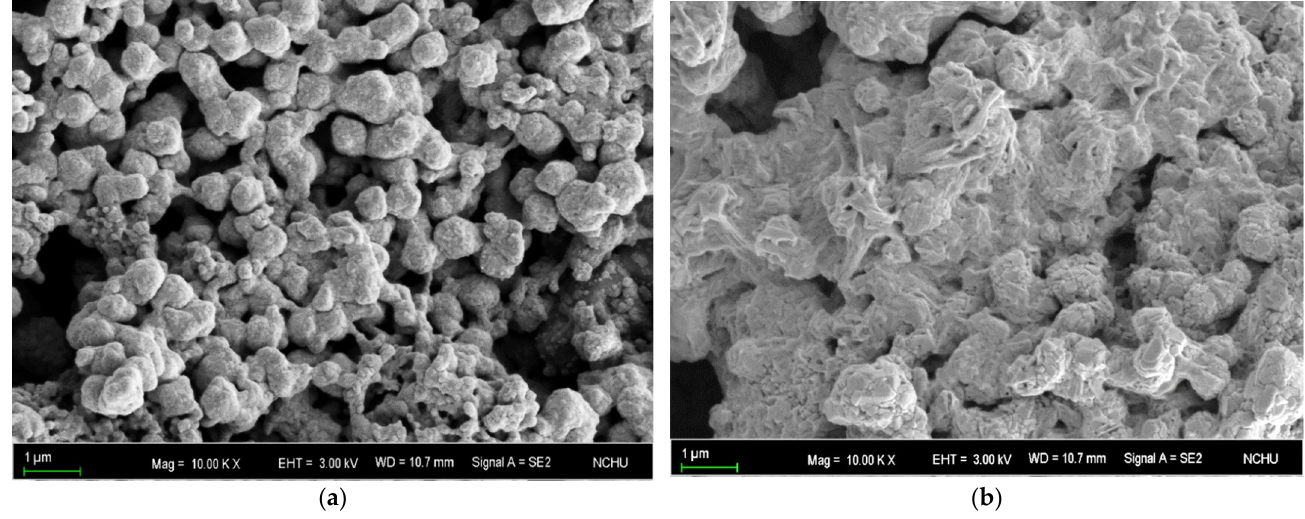
Figure 6. SEM image of sintered hybrid copper pastes ( a ) without copper salts, and ( b ) with copper formate.